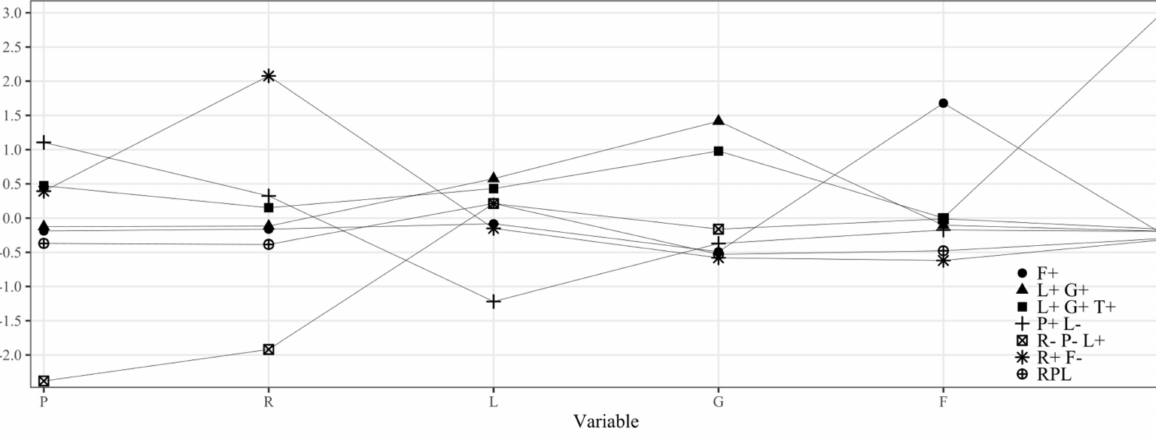
Figure 9. The mean values of the indicators over clusters in parallel coordinates. All clusters are unique in terms of their mean